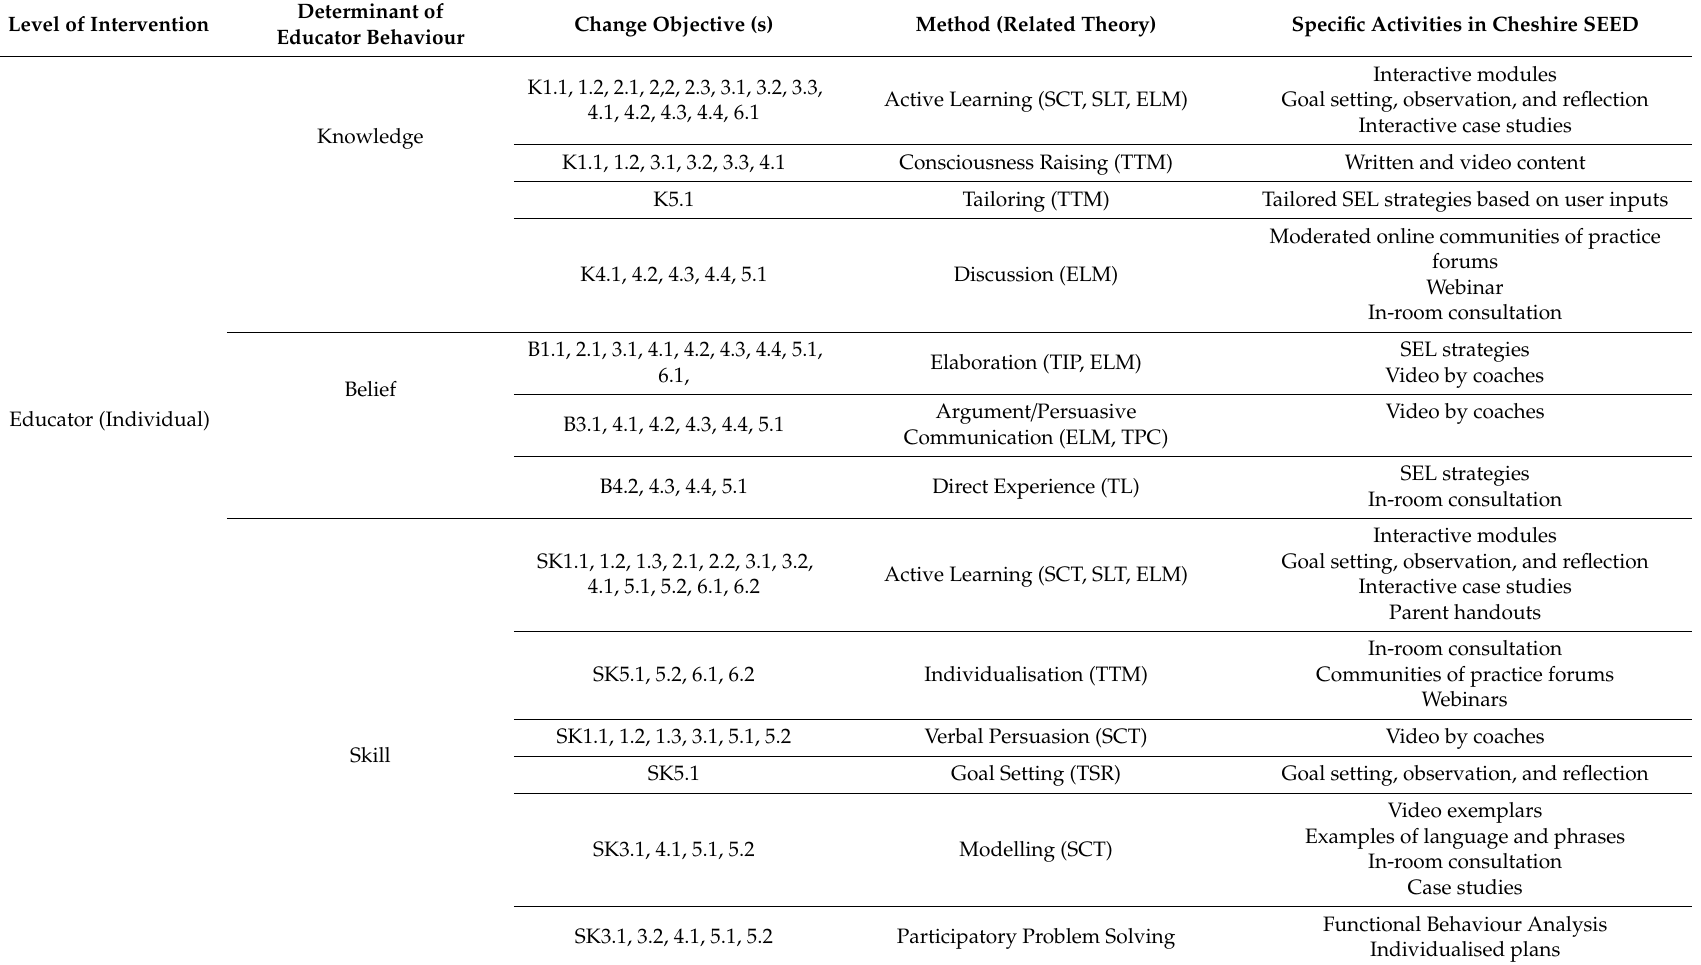
Table 4. Examples of Strategies to Achieve Change Objectives for